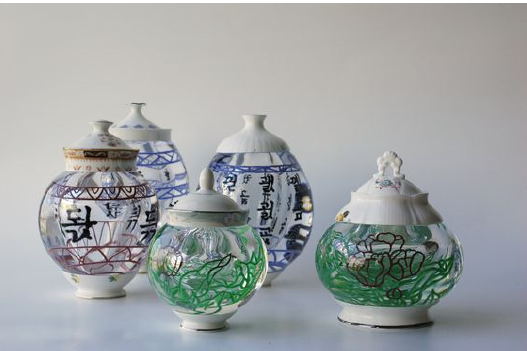
Figure 19. Choi Keeryong, Korean Glass; blown glass with colour inlay and English manufactured porcelain parts (2014). Courtesy of the artist, used with permission.